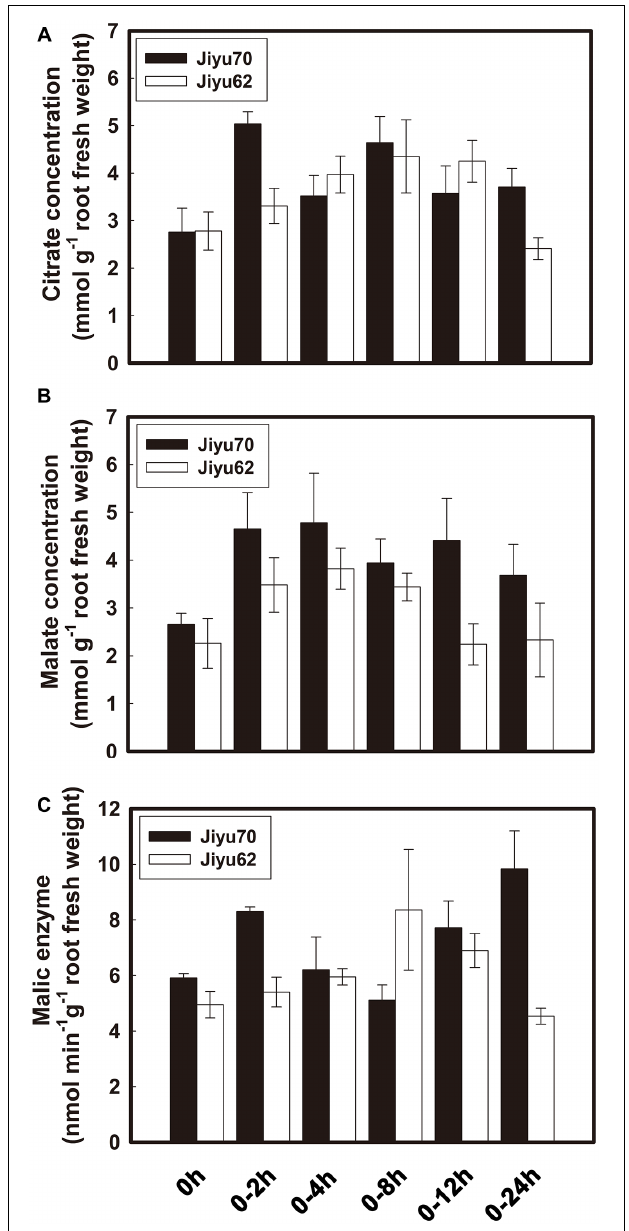
FIGURE 2 | The time course of internal citrate (A) , malate (B) , and NADP-malic enzyme (C) concentration in root apices of two soybean genotypes. Soybean seedlings were transferred to 0.5 mM CaCl 2 solution (pH 4.5) with or without 30 µ M AlCl 3 . The root apices of soybean were excised at 2, 4, 8, 12, and 24 h. Internal malate, citrate and malic enzyme were extracted and examined. Error bars represent ± SD ( n =